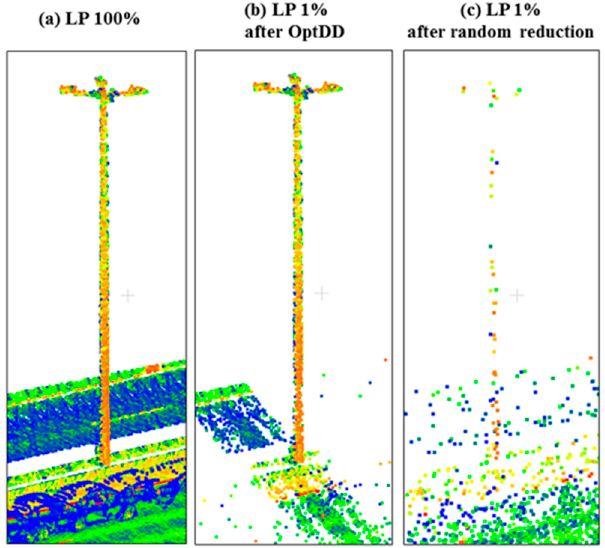
Figure 6. Point cloud of LP: ( a ) original LP, ( b ) LP after OptD method, ( c ) LP after random reduction.